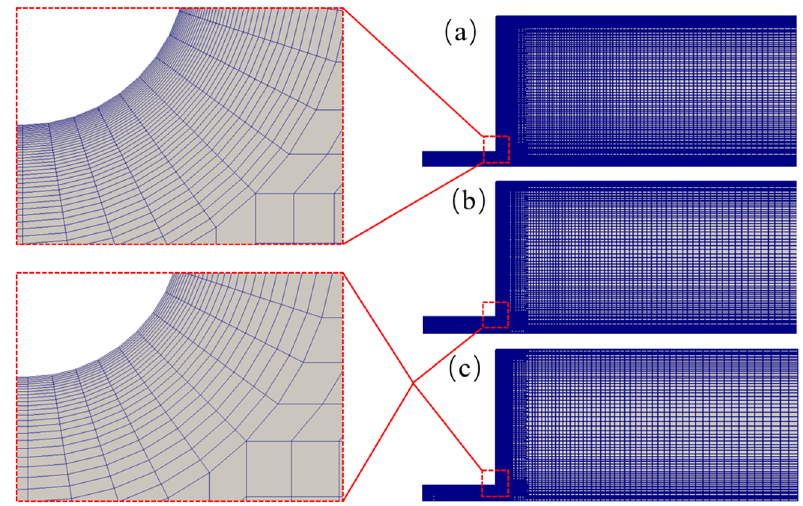
Figure A1. Three different meshes used for the mesh independence study. The meshes are symmetric with respect to the x -axis and y -axis, and only 1/4 of the total meshes are showed. ( a ) Mesh 1: 135.192 cells. ( b ) Mesh 2: 95.252 cells. ( c ) Mesh 3: 77.192 cells.